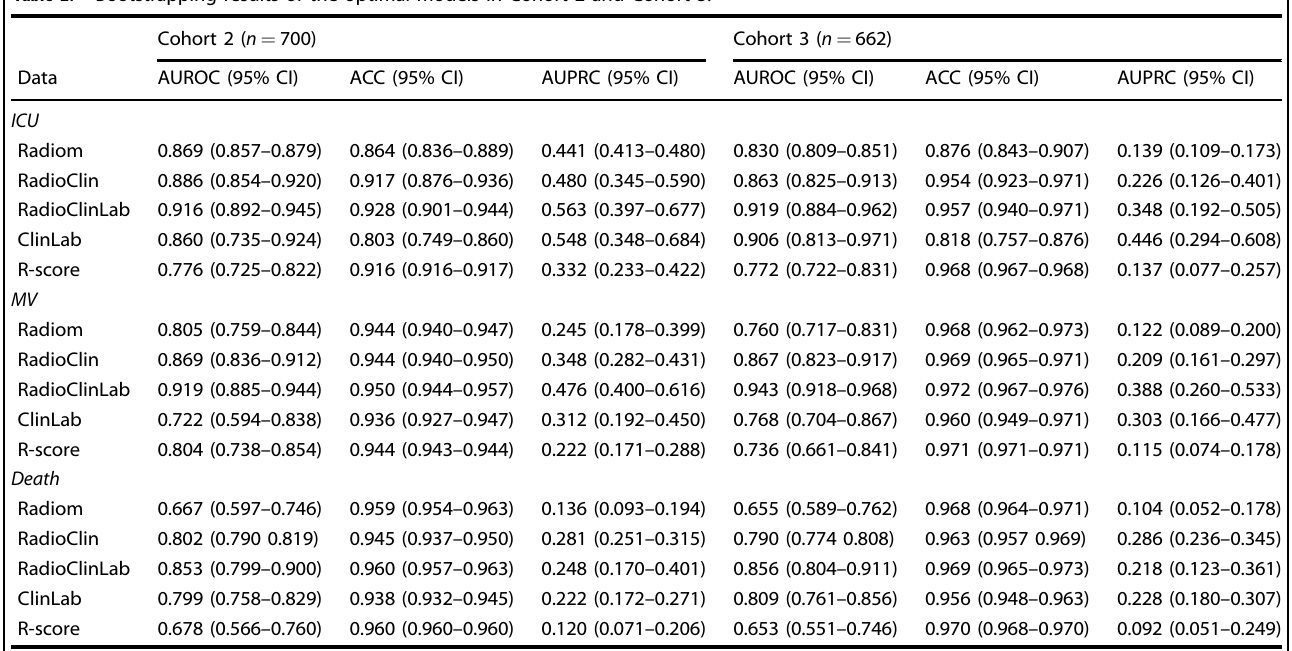
Table 2. Bootstrapping results of the optimal models in Cohort 2 and Cohort